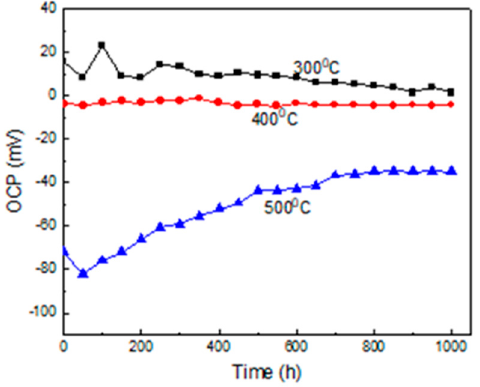
Figure 2. Effect of temperature on the variation of the OCP value for T91 steel in 60 wt% NaNO 3- 40%KNO 3 .